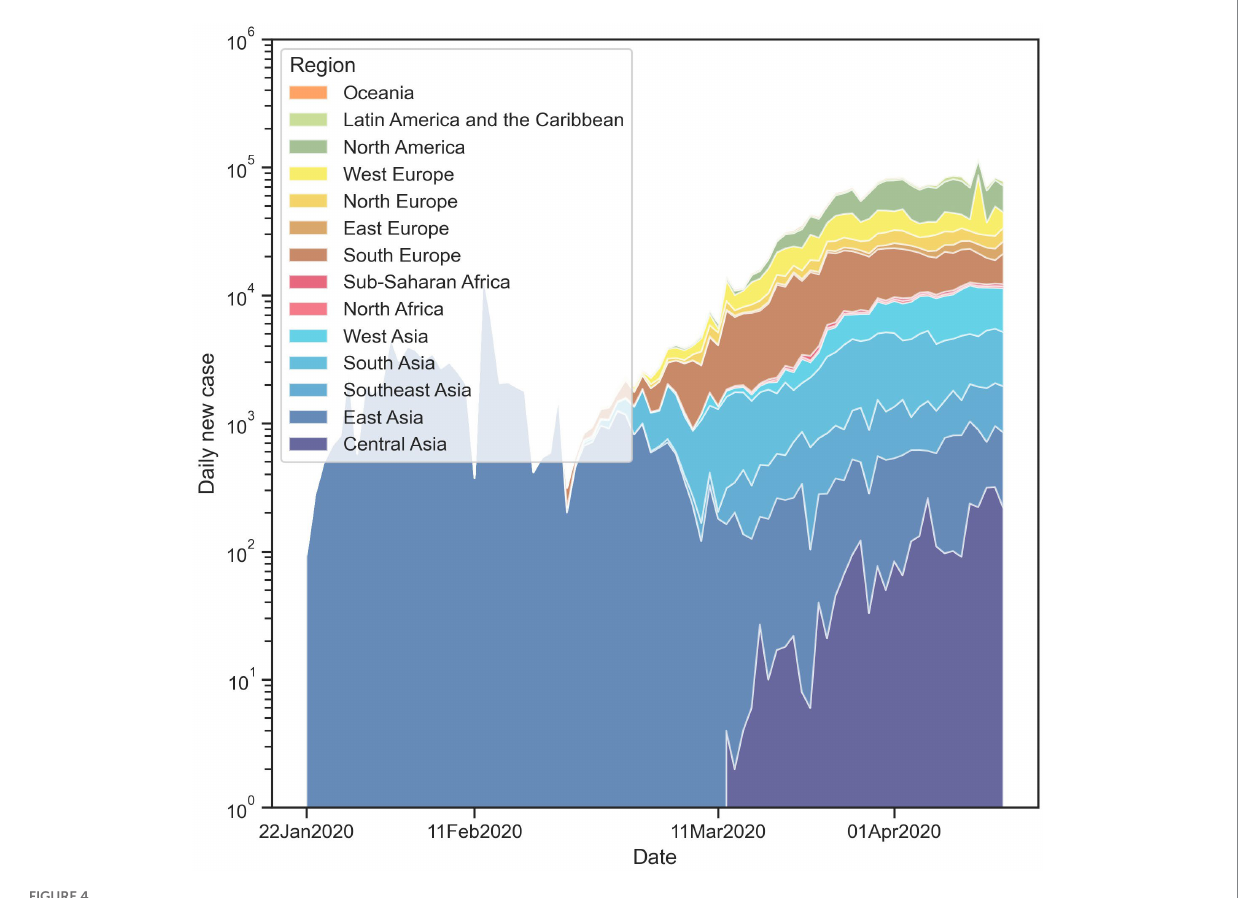
FIGURE 4 Temporal variation of daily new case number across different